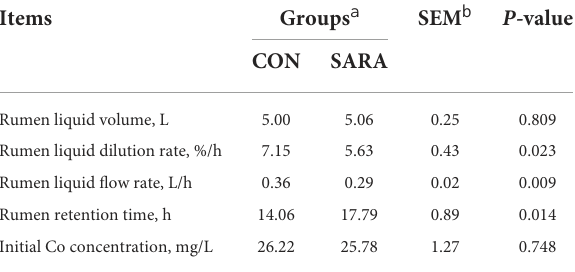
TABLE 5 Effect of subacute rumen acidosis on ruminal outflow parameters.